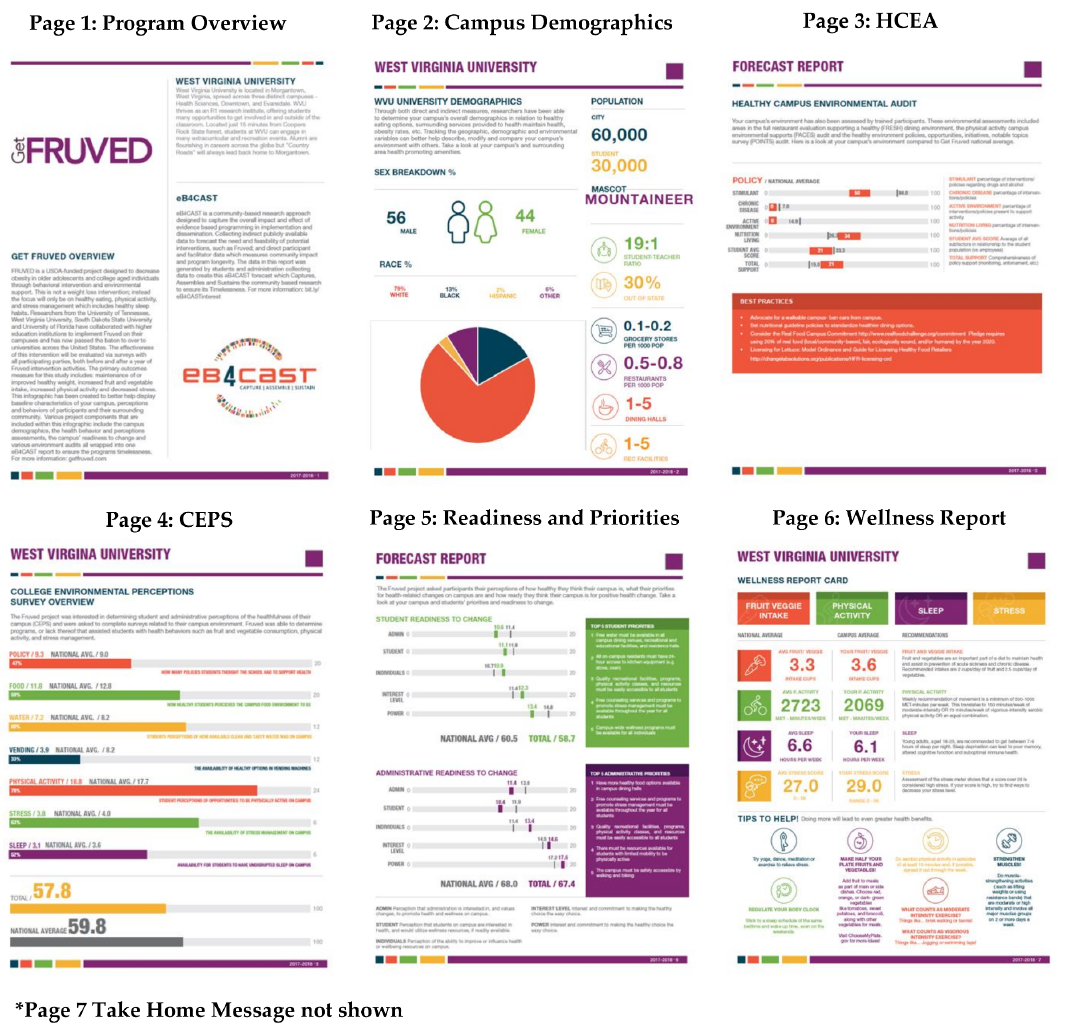
Figure 3. Sample eB4CAST infographic reports from